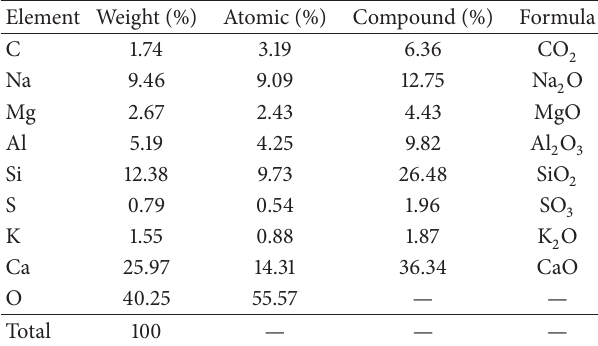
Table 4: Presence of elements in EDX